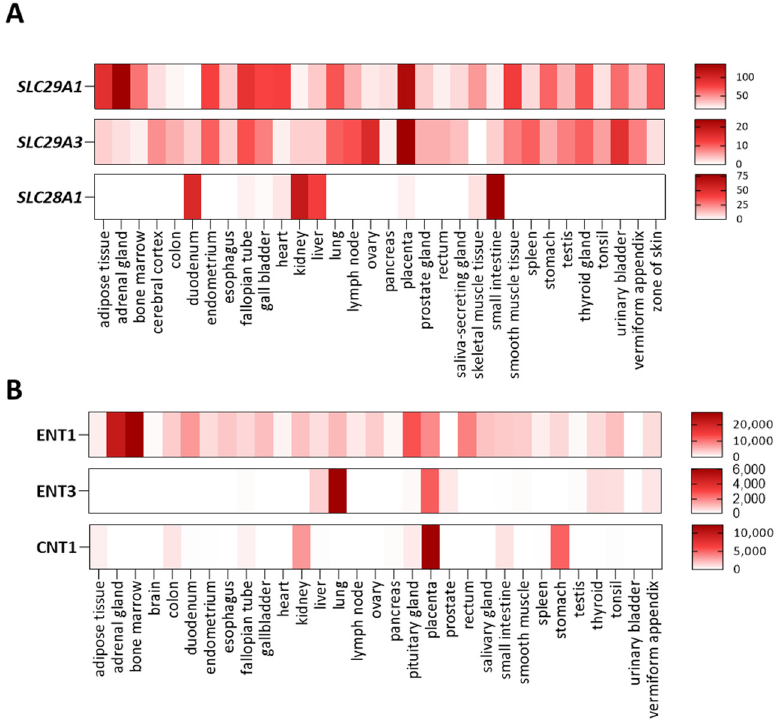
Figure 2. Nucleoside transporter expression patterns and substrate selectivity. Heat-maps showing the tissue expression of SLC29A1 (ENT1), SLC29A3 (ENT3) and SLC28A1 (CNT1) at the mRNA ( A ) and protein ( B ) levels; data obtained from the EMBL-EBI database.